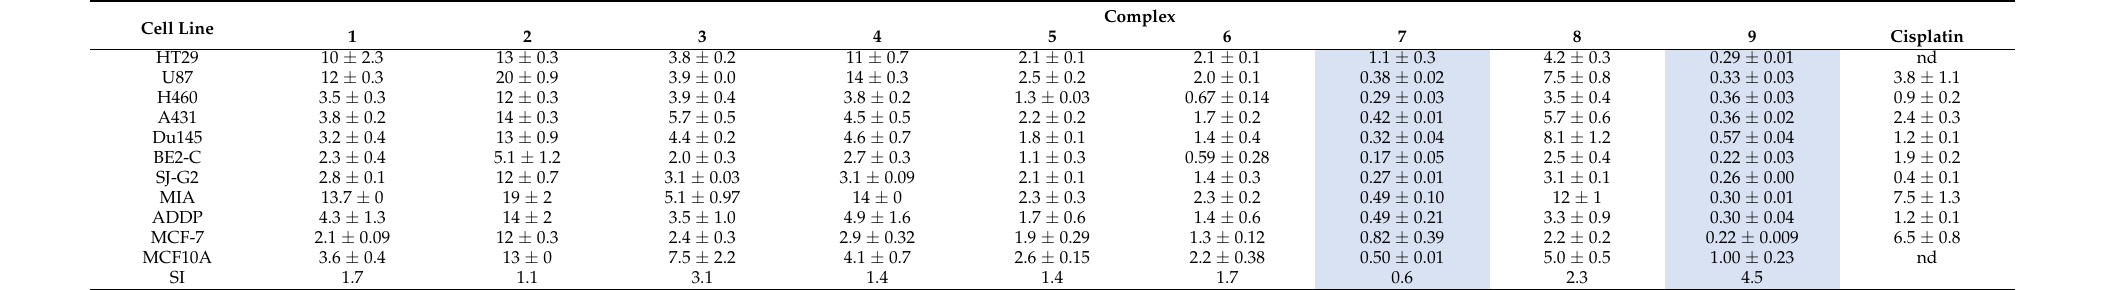
Table 2. GI 50 data for each of the nine complexes compared to